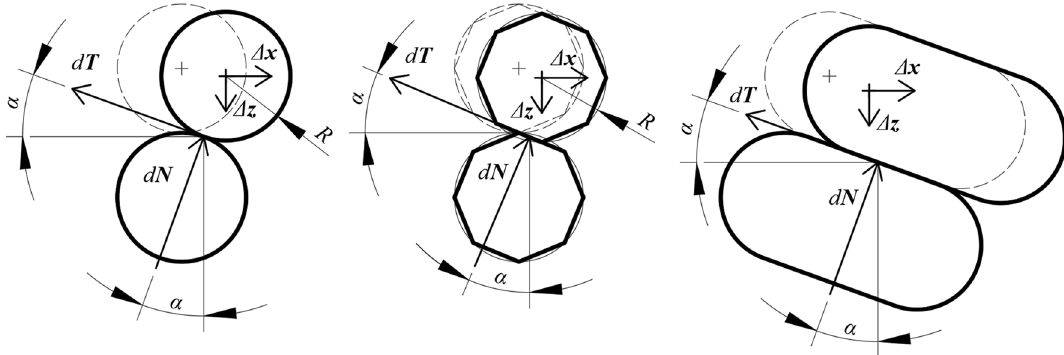
Figure 1. Diagram of the work of particles during